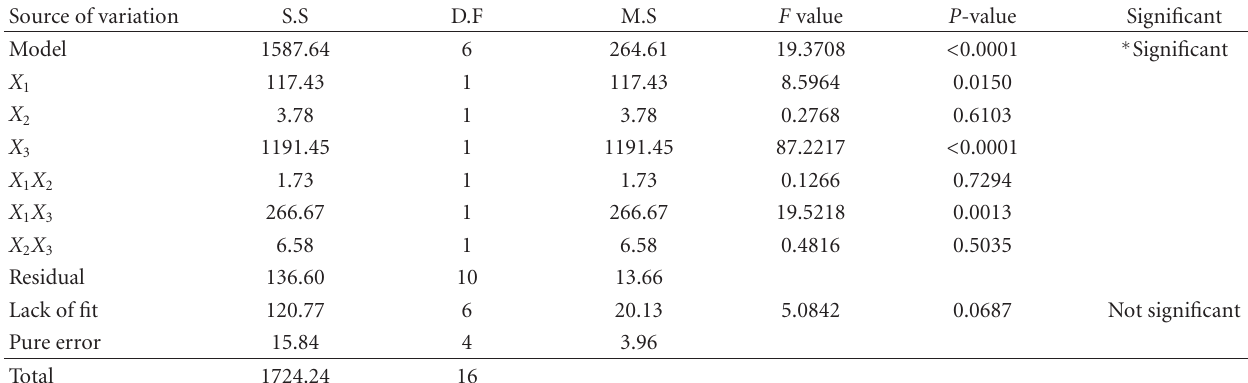
Table 5: Analysis of variance for response surface 2FI model (partial sum of squares, typeIII). Source of variation